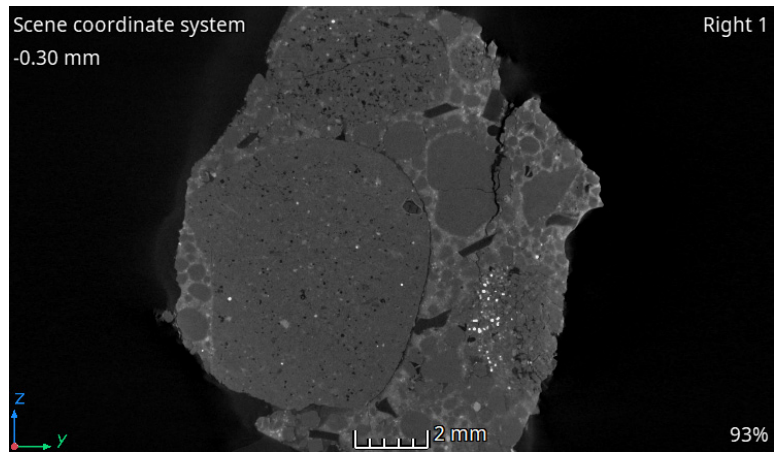
Figure 8. X-ray CT scan—section of a fragment of an SCC-P-15 sample after